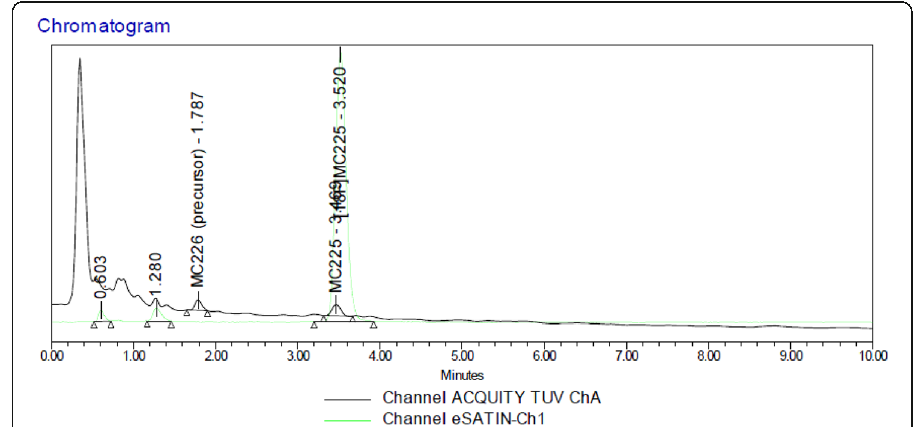
Fig. 8 Final product injected into the UPLC system. [ 18 F]MC225 elutes at 3.5